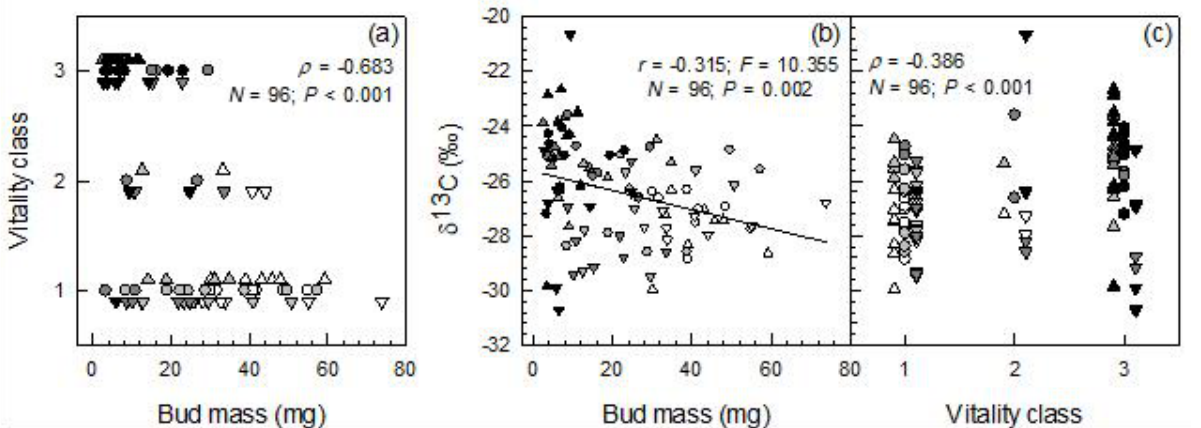
Figure 2. ( a ) Bud vitality classes vs. individual bud mass; ( b ) bud δ 13 C vs. individual bud mass; ( c ) bud δ 13 C vs. bud vitality in European beech saplings. The bud vitality classes ranged from 1, high vitality and flushing probability to 3, low vitality and flushing probability. Buds were harvested from different parts of the crown (triangles up, upper part; circles, middle part; triangles down, lower part) of saplings assigned to different drought damage classes (DC; white symbols = DC1,